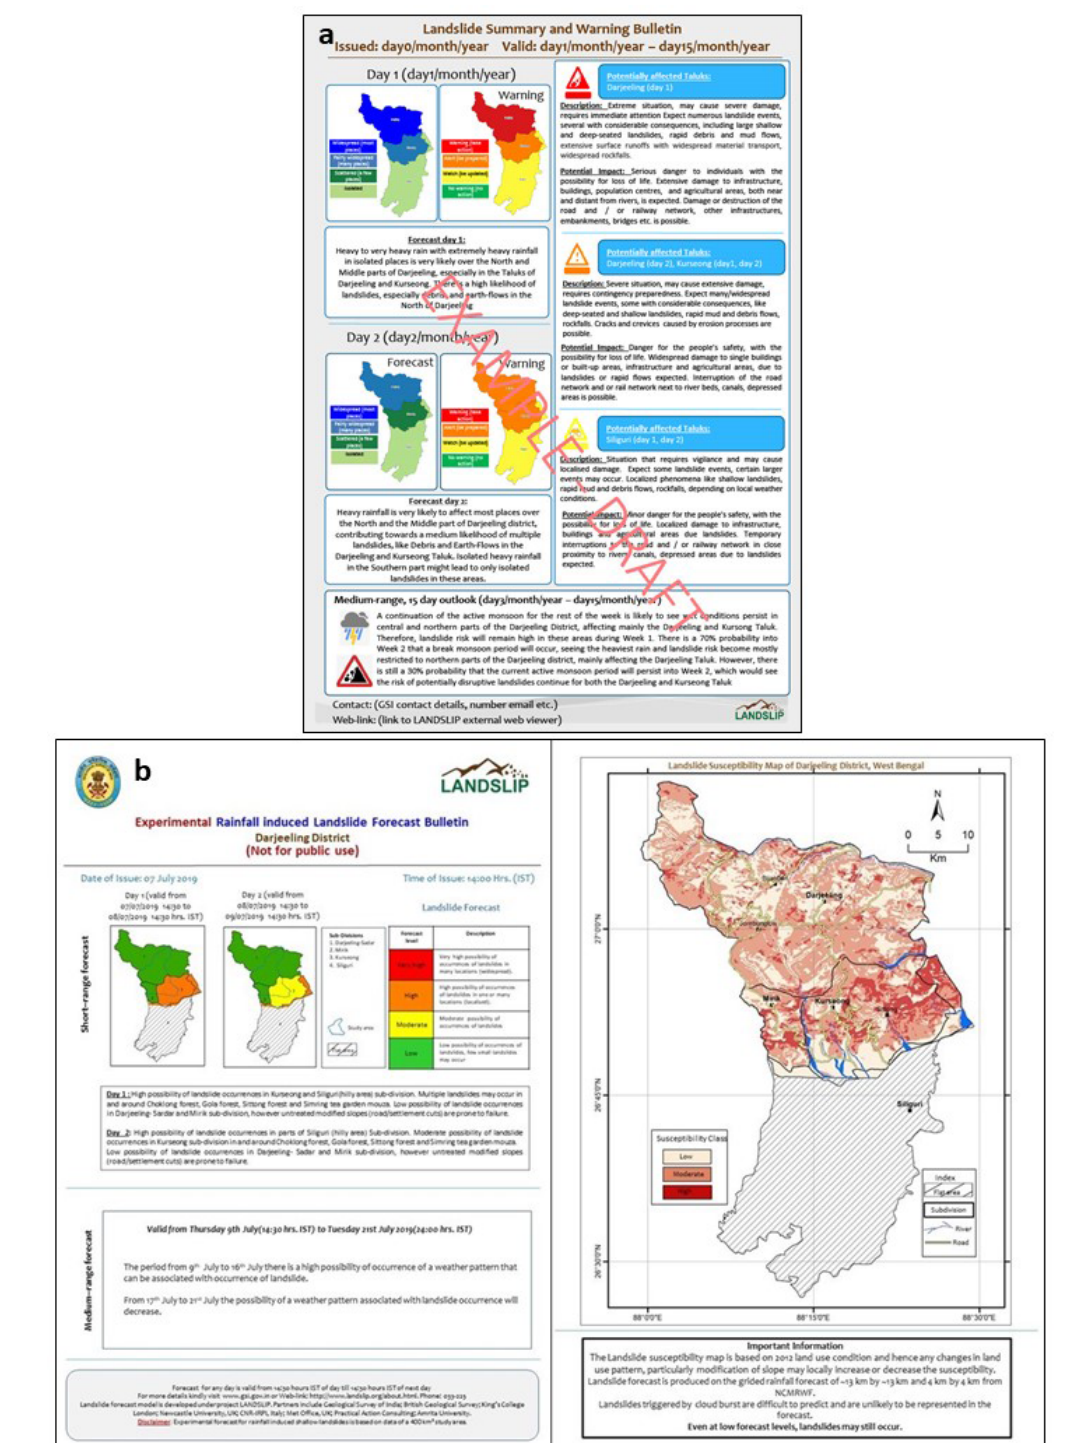
Figure 2. Examples of prototype landslide forecast bulletins for Darjeeling, India, produced as part of LANDSLIP’s experimental regional landslide early warning system: (a) January 2019 prototype version and (b) June 2019 prototype version (LANDSLIP, 2019 (Landslide Multi-Hazard Risk Assessment, Preparedness and Early Warning in South Asia: Integrating Meteorology, Landscape and Society), prototype landslide forecast bulletin examples for Darjeeling District, versions from January and June 2019 produced by UK NERC/FCDO